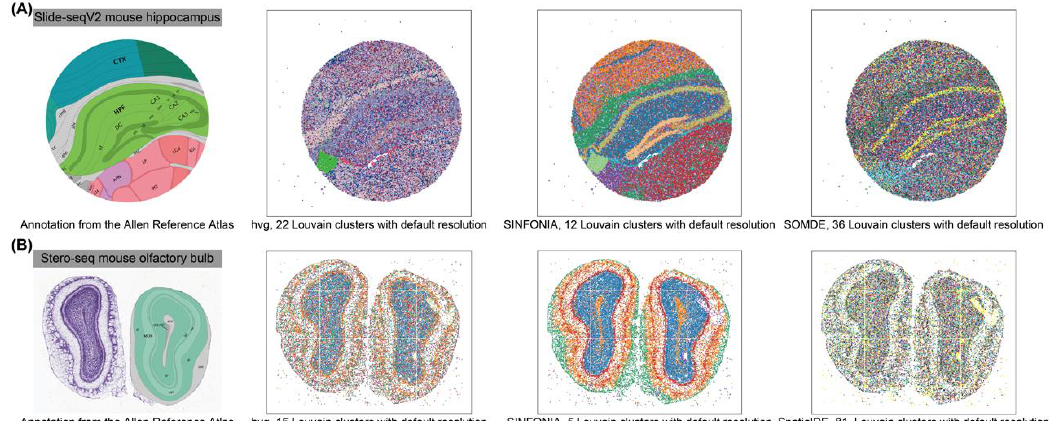
Figure 5. Visualization of datasets of ( A ) a mouse hippocampus and ( B ) a mouse olfactory bulb with tissue regions annotated from the Allen Brain Atlas and spatial domains detected by different methods.